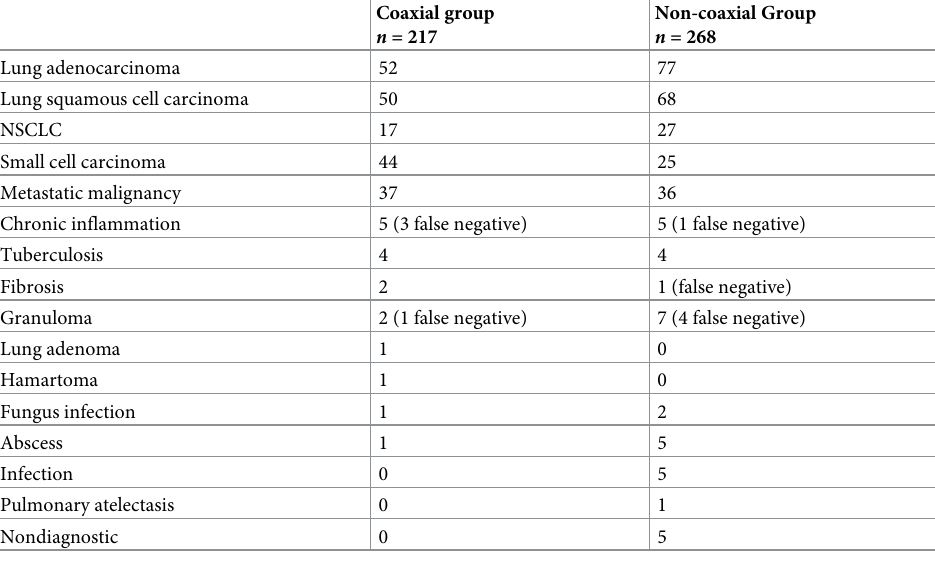
Table 3. The histopathologic results of the two